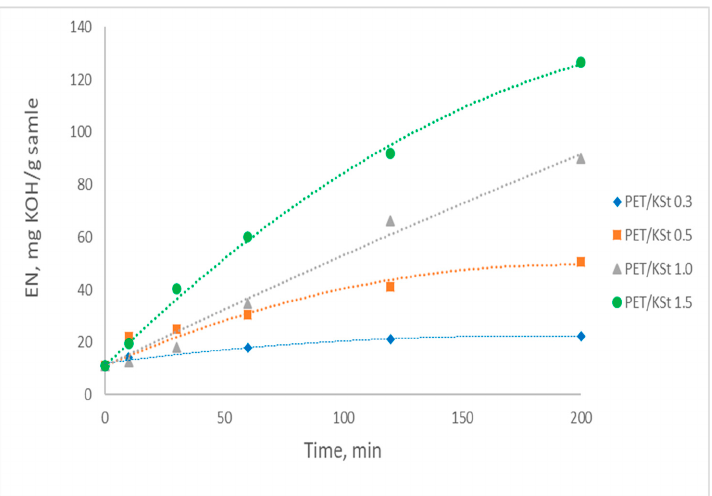
Figure 8. The change in the ether number of the reaction mass over time during the depolymerization of crude glycerol at 190 °C and a different PET/KSt ratio.